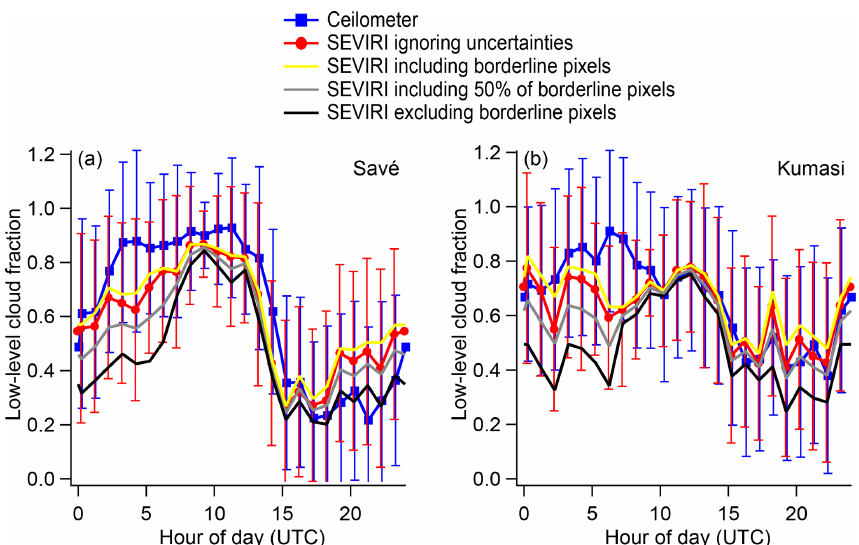
Figure A2. Comparison of LLC fraction derived from satellite and ground-based ceilometer measurements from Savé (a) and Kumasi (b) . The satellite measurements were calculated from a 4pixel × 4pixel grid centred on the ground